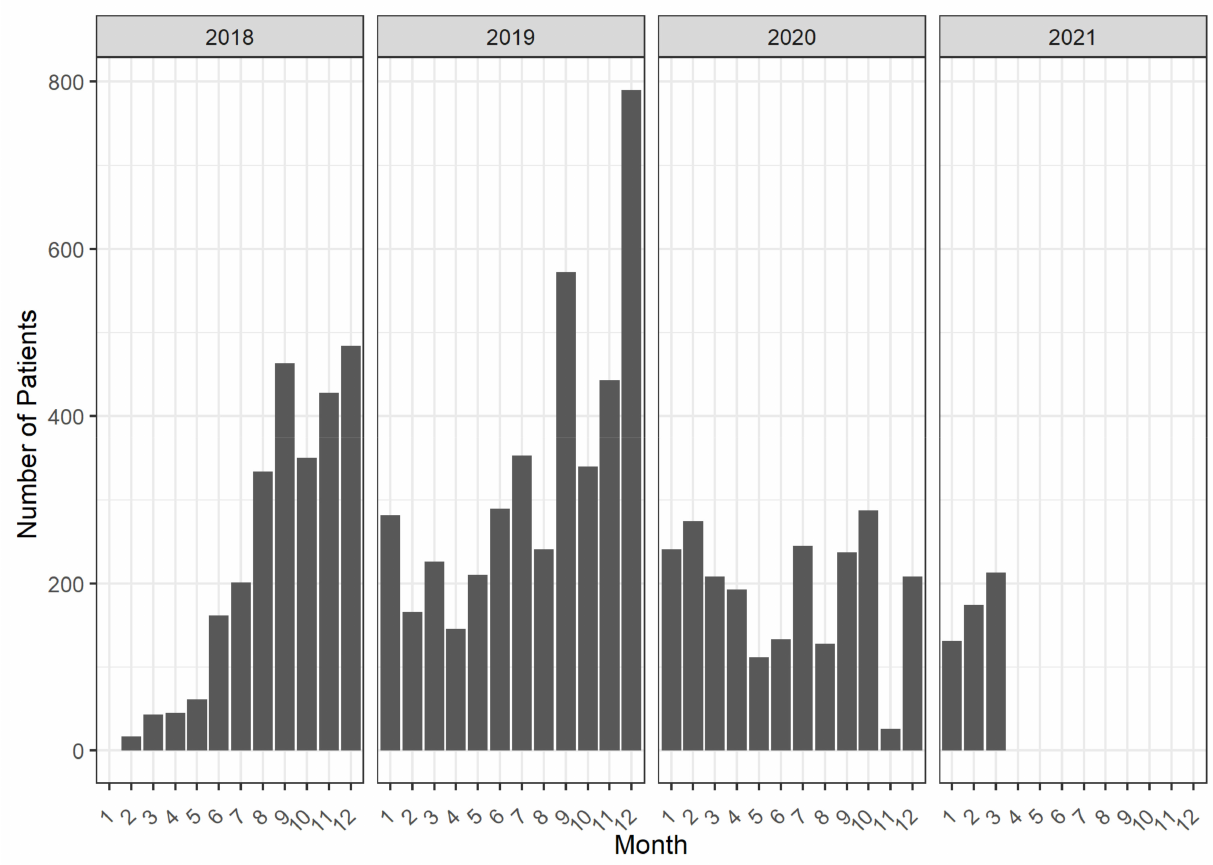
Figure 8. Number of patients, stratified by the month and year when T 0 was triggered over the course of the